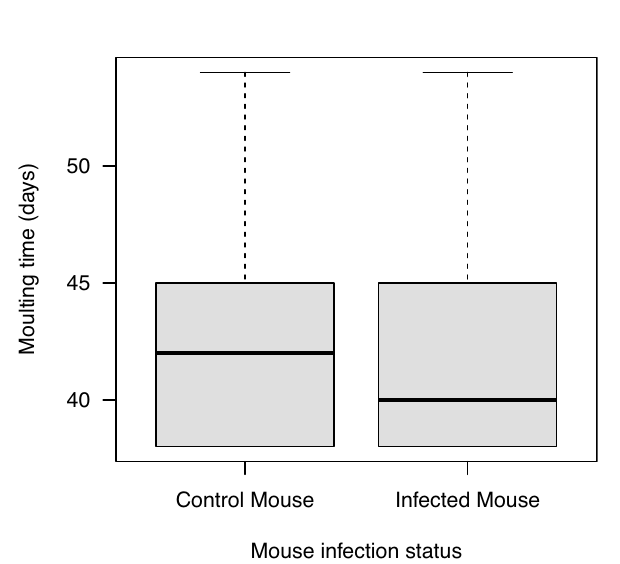
vidual tick accounted for 8.0%, 5.8%, and 86.3% of the variance, respectively. Similarly, for the unfed nymphal weight (log10-transformed), variance component analysis found that tick family, mouse ID, and the individual tick accounted for 7.9%, 4.0% and 88.1% of the variance, respectively. Thus, most of the variance in immature tick weight occurred at the level of the individual ticks and was unexplained. Correlations between the life history traits of immature I. ricinus ticks. There were five signifi- cant correlations between the six variables, which included the number of engorged larvae that were recovered